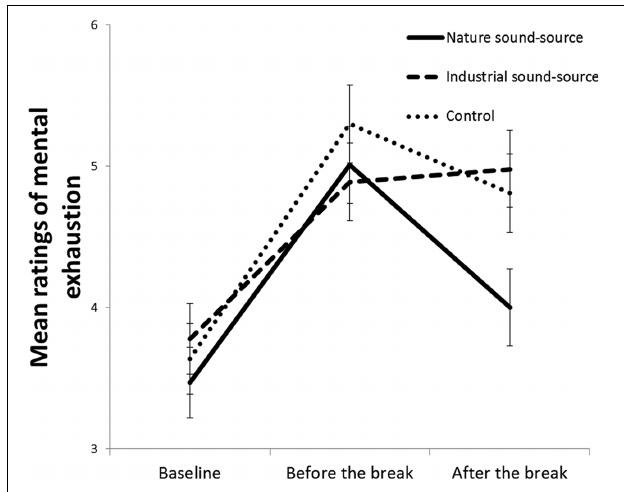
FIGURE 2 | Mean ratings of the mental exhaustion index across the three times of data collection for the three sound-source conditions. Error bars represent standard error of means.